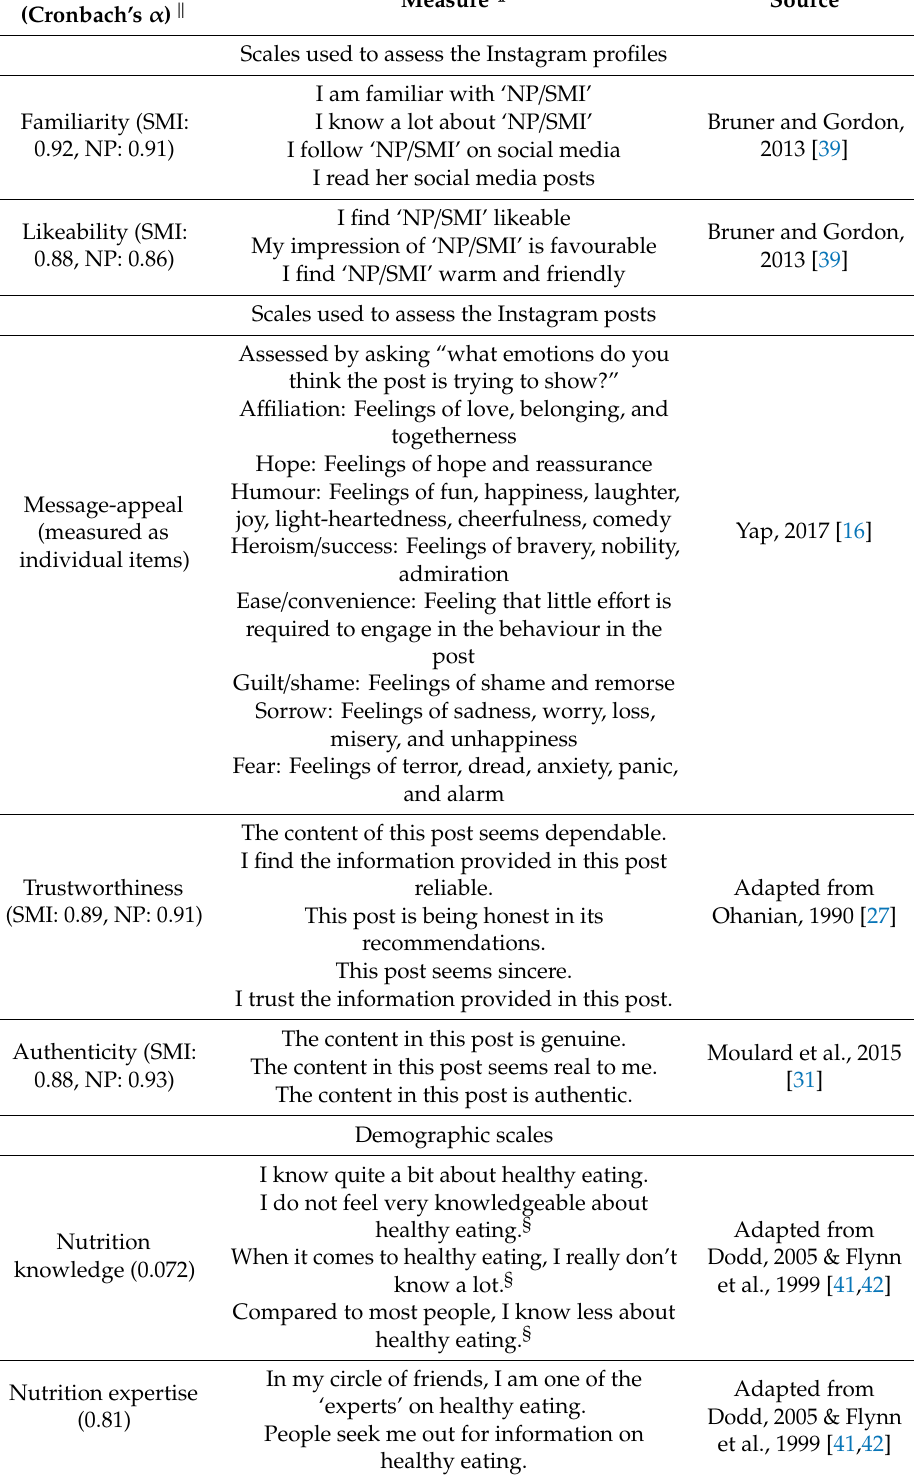
Table 2. Constructs and their associated items from scales used in the questionnaire.